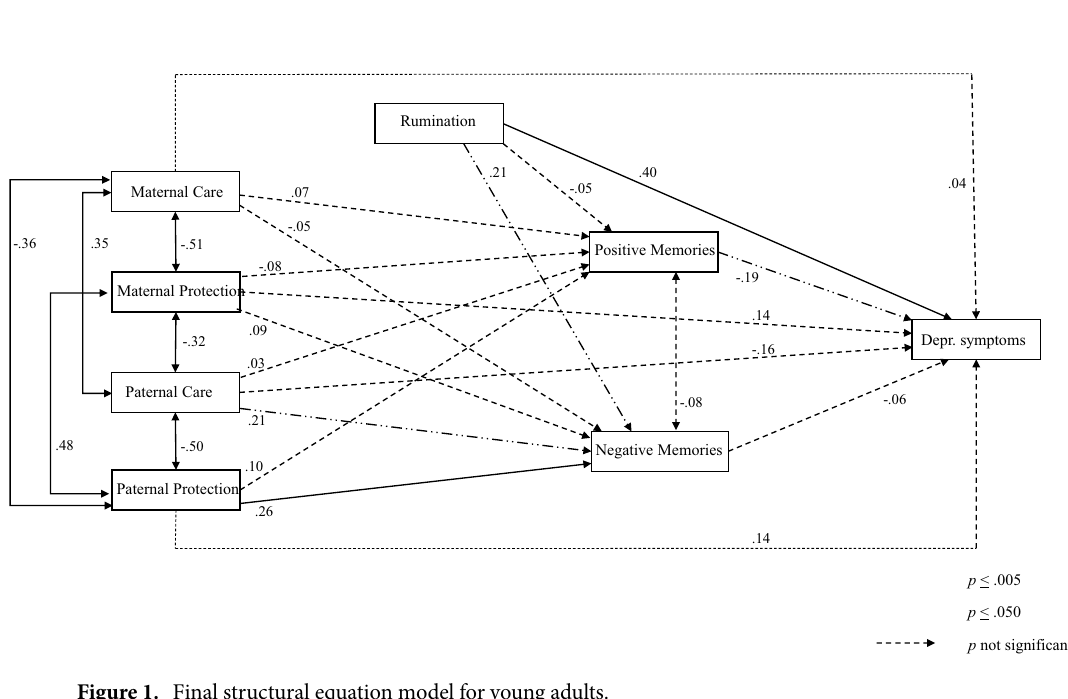
Figure 1. Final structural equation model for young